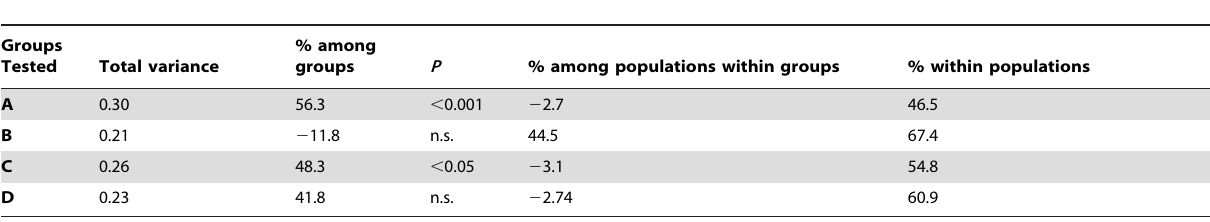
Table 4. Apportionment of molecular variance measured among populations of An. Gambiae.